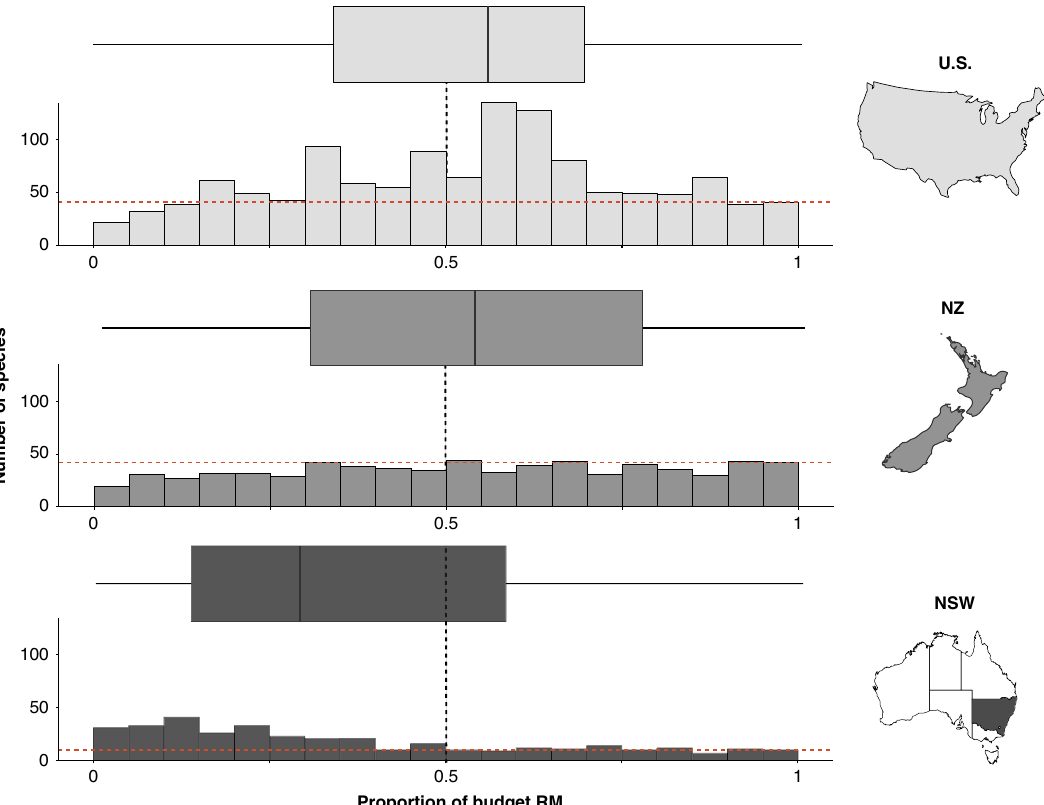
Fig. 1 Proportion of the budget allocated to research and monitoring for threatened species ( n = 2261 species in three jurisdictions: United States (U.S.), New Zealand (NZ), and New South Wales (NSW)). The stippled red line indicates the number of species with >95% of the budget allocated to research and monitoring (RM). The box and whiskers show the proportion of recovery plan budgets allocated to research and monitoring in each jurisdiction, with the median as a line, fi rst and third quartiles as hinges, and the highest and lowest values within 1.5 times the inter-quartile range as whiskers. The black stippled line indicates the mean among jurisdictions (50%). Maps were created in ArcGIS for Desktop (10.3, ESRI Inc.,